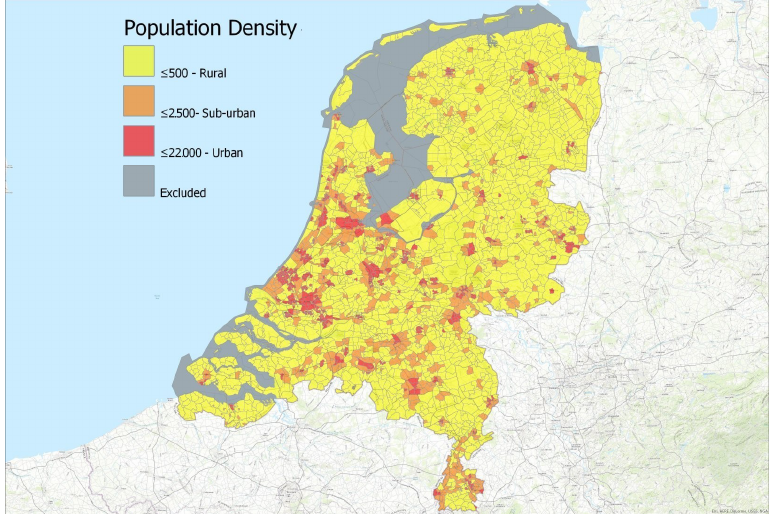
Figure 1. Map division in urban, suburban and rural areas in the Netherlands based on population